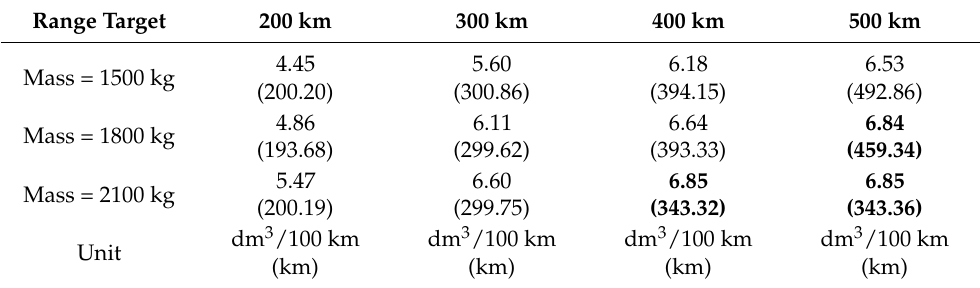
Table A9. Fuel consumption in EREV mode for WLTC 3b Extra-High 3.